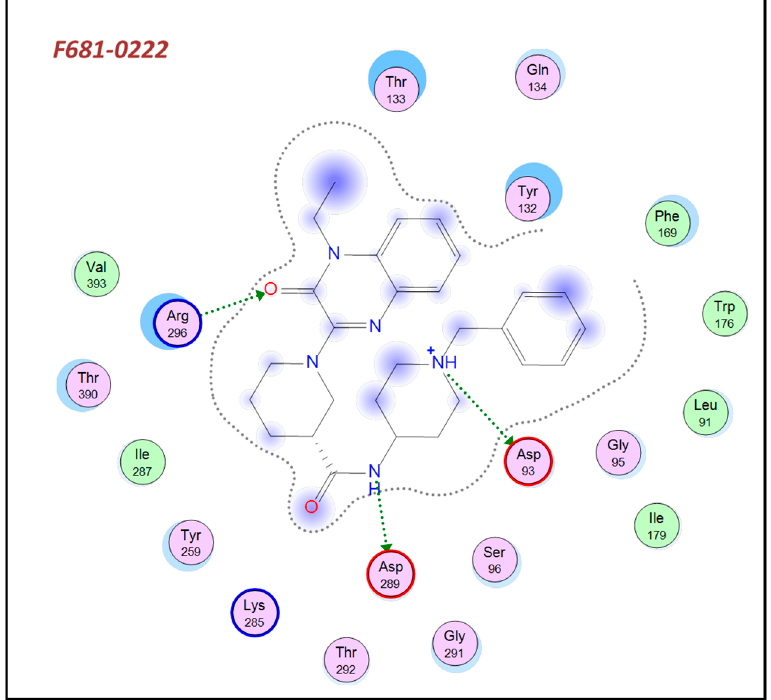
Figure 7. The interactions of hit molecule 2 with binding site residues of BACE-1 Asp93 deprotonated structure. Both of the catalytic aspartates form hydrogen bonds with the hit molecule.